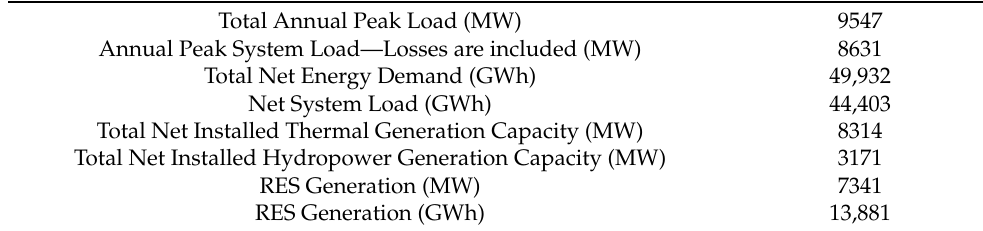
Table 1. Main characteristics of the interconnected power system of Greece (2020 data). Total Annual Peak Load (MW) 9547 Annual Peak System Load—Losses are included (MW) 8631 Total Net Energy Demand (GWh) 49,932 Net System Load (GWh) 44,403 Total Net Installed Thermal Generation Capacity